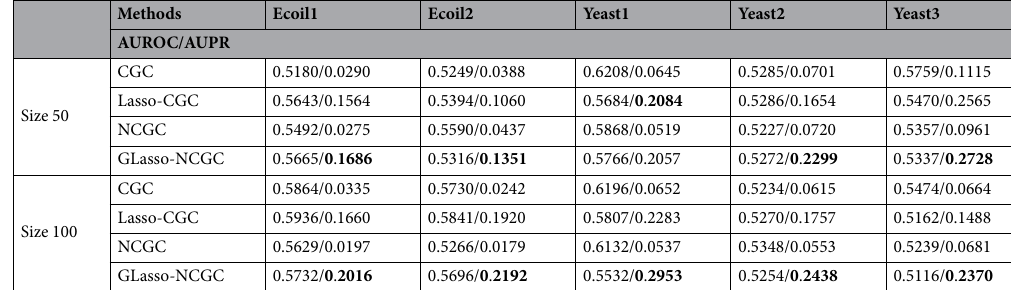
Table 6. Comparison of different methods on DREAM3 Challenge4 In-Silico networks with Size 50 and Size 100.